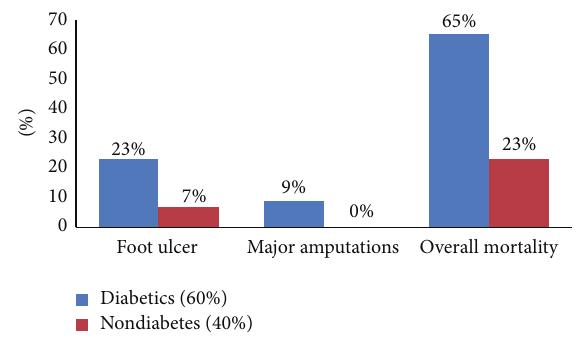
Figure 2: Outcomes in HD patients based on the presence of DM ( 𝑃 = 0.001 for all).